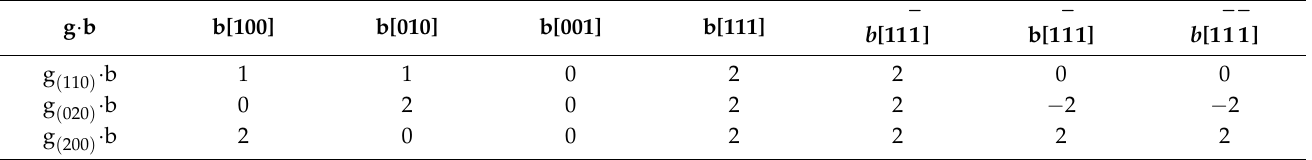
Table 3. The g · b value when imaged under [001] zone